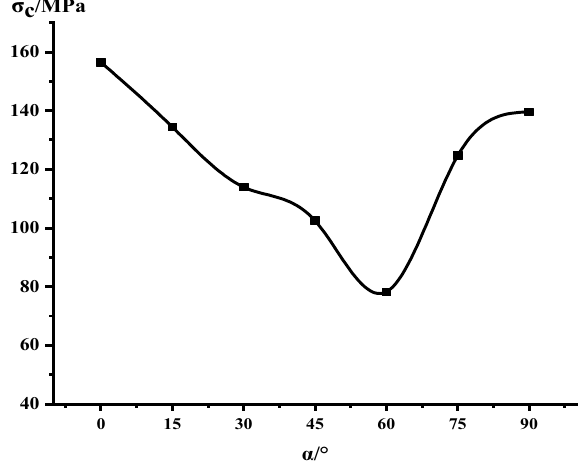
Figure 8. Uniaxial peak compressive strength as a function of joint angle.